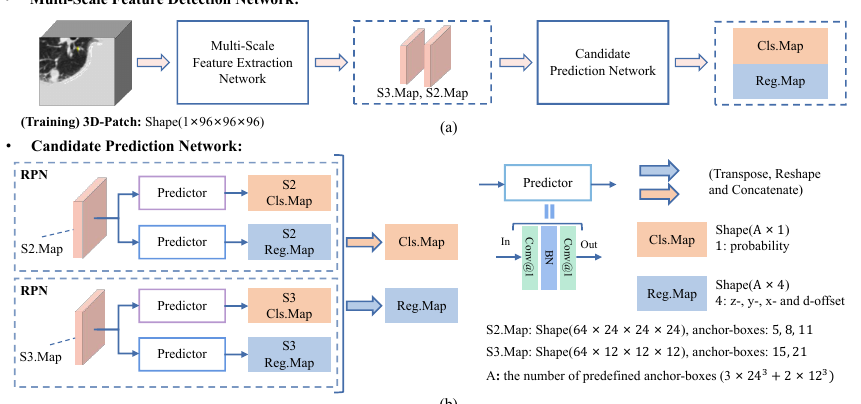
Figure 6. Flowchart of the proposed multi-scale feature detection network (MSFD-Net). ( a ) The MSFD- Net consists of a multi-scale feature extractor and candidate prediction network (CPN). ( b ) The CPN predicts one classification map (Cls.Map) and four regression offset maps (Reg.Map) of candidates at two scales,